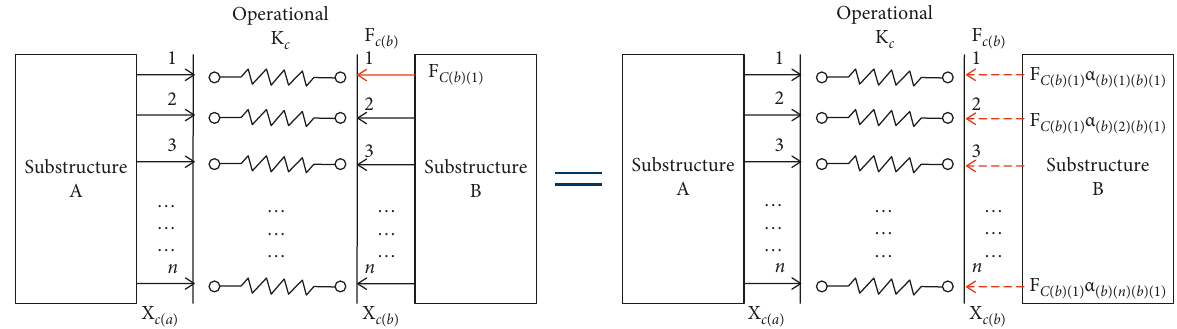
Figure 4: Original model (left side) and imaginary model (right